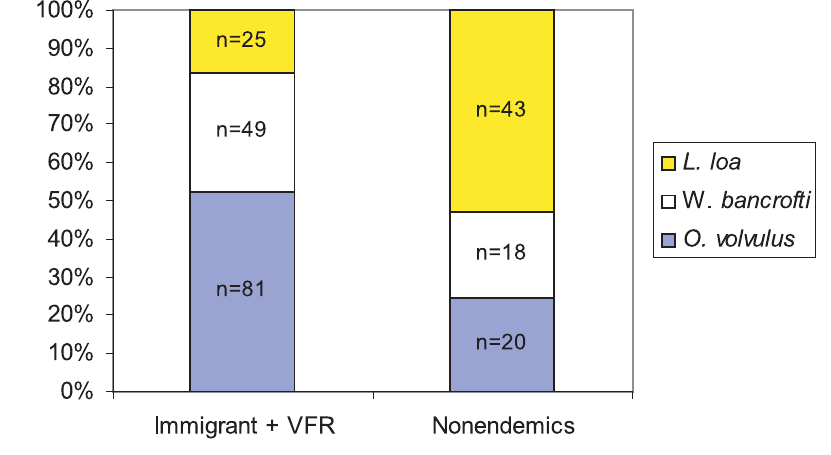
Figure 4. Regional distribution of filarial infections among immigrants, VFR, and nonendemic visitors reported in the GeoSentinel Surveillance Network.